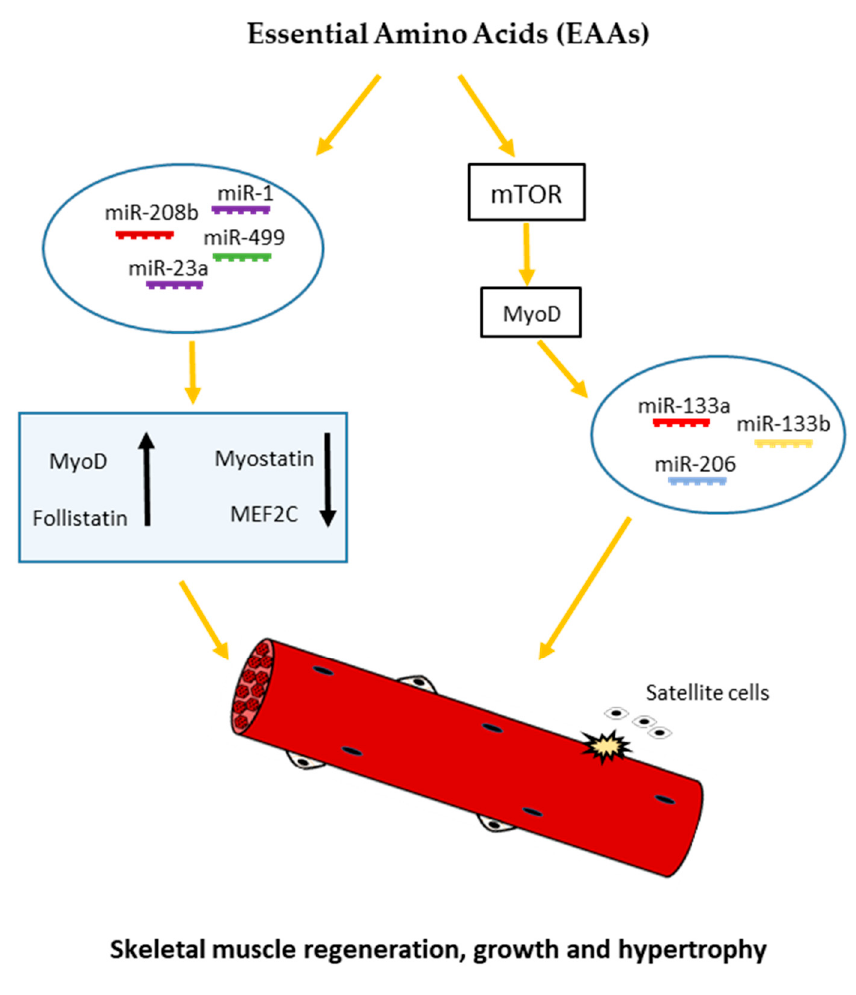
Figure 2. Schematic representation of nutrient-dependent-miRNA signaling in skeletal myogenesis. Nutrients such as essential amino acids (EAAs) may affect the expression of miR-133a/b and miR-206 through mTOR-dependent regulation of MyoD mRNA levels. On the other hand, EAAs may elicit robust increases in miR-1, miR-23a, miR-208b, and miR-499 expression, with an accompanying increase in MyoD and follistatin mRNA and decrease in myostatin and MEF2C mRNA expression, regulating skeletal muscle growth and differentiation.